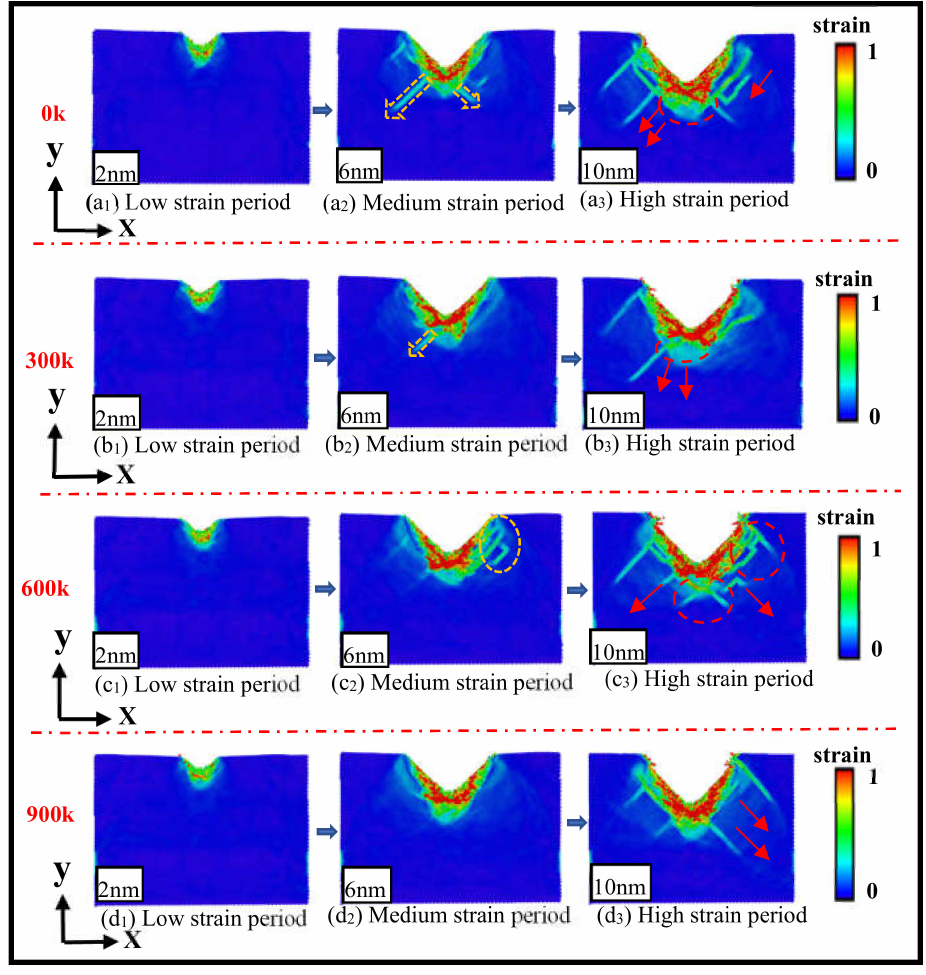
Figure 3. Deformation comparison analysis of different temperature indentation